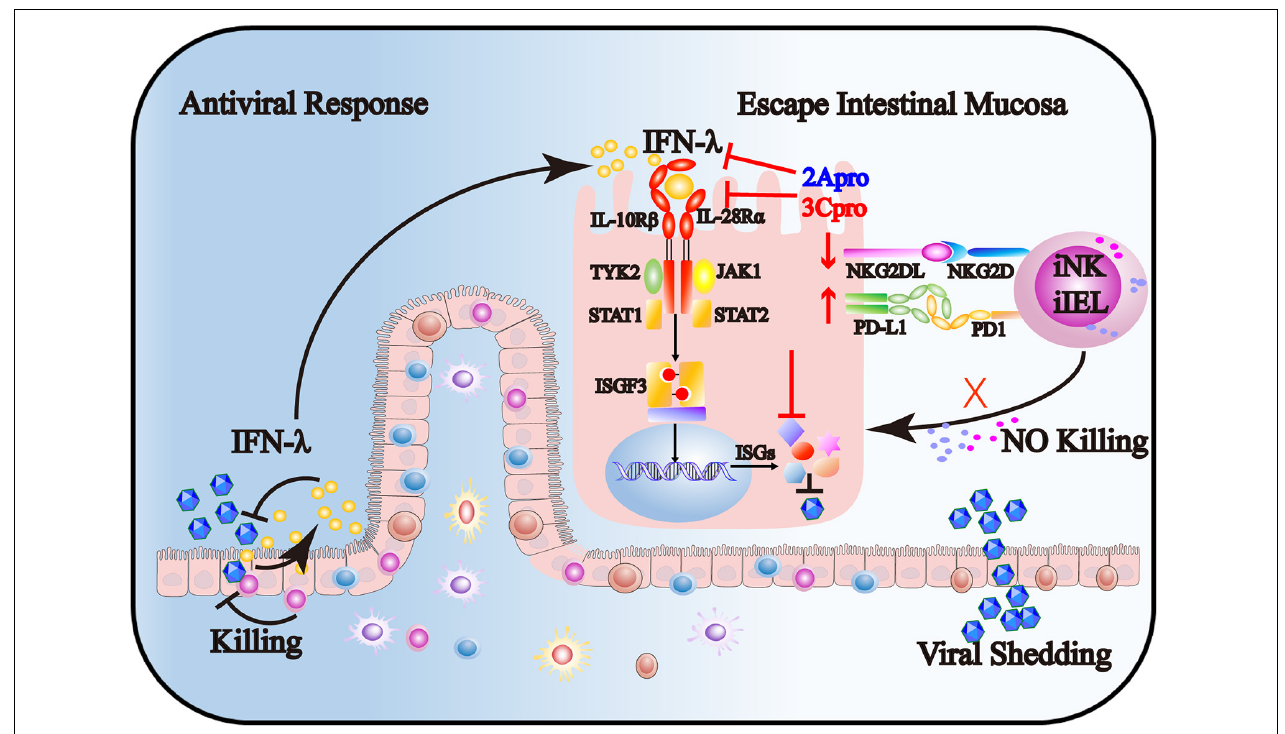
FIGURE 9 | The 2Apro and 3Cpro of enterovirus 71 inhibit the IFN- λ production and IFN- λ receptor expression and further decrease the response of IECs to IFN- λ . Also, 2Apro and 3Cpro reduce the susceptibility of IECs to iNK and CD3 + iIELs lysis, possibly by down-regulation of NKG2DL and up-regulation of